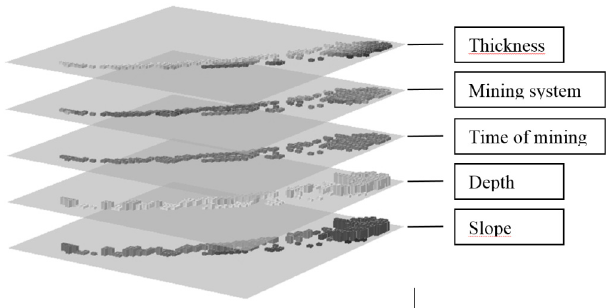
Figure 8. Three-dimensional visualisation of the coal thickness, mining system, time of mining, depth below the ground and slope variables derived for a selected coal production level and used for spatial data classification.